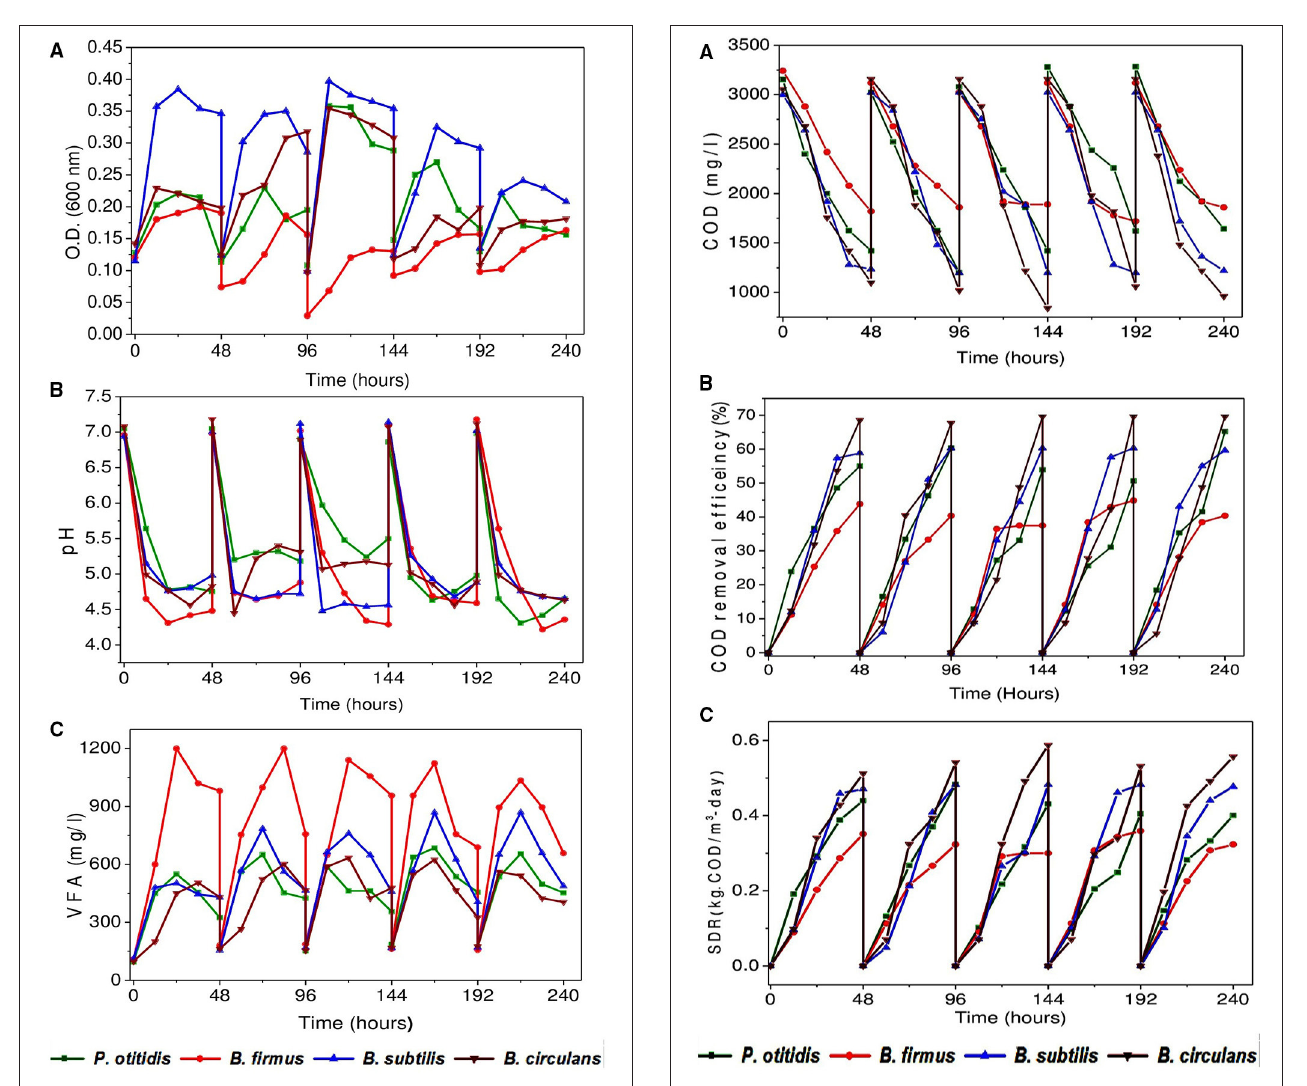
FIGURE 2 | (A) Bacterial growth of isolated strains in synthetic wastewater (B) pH variation with time (C) Variation in Volatile fatty acids (VFA) with time.